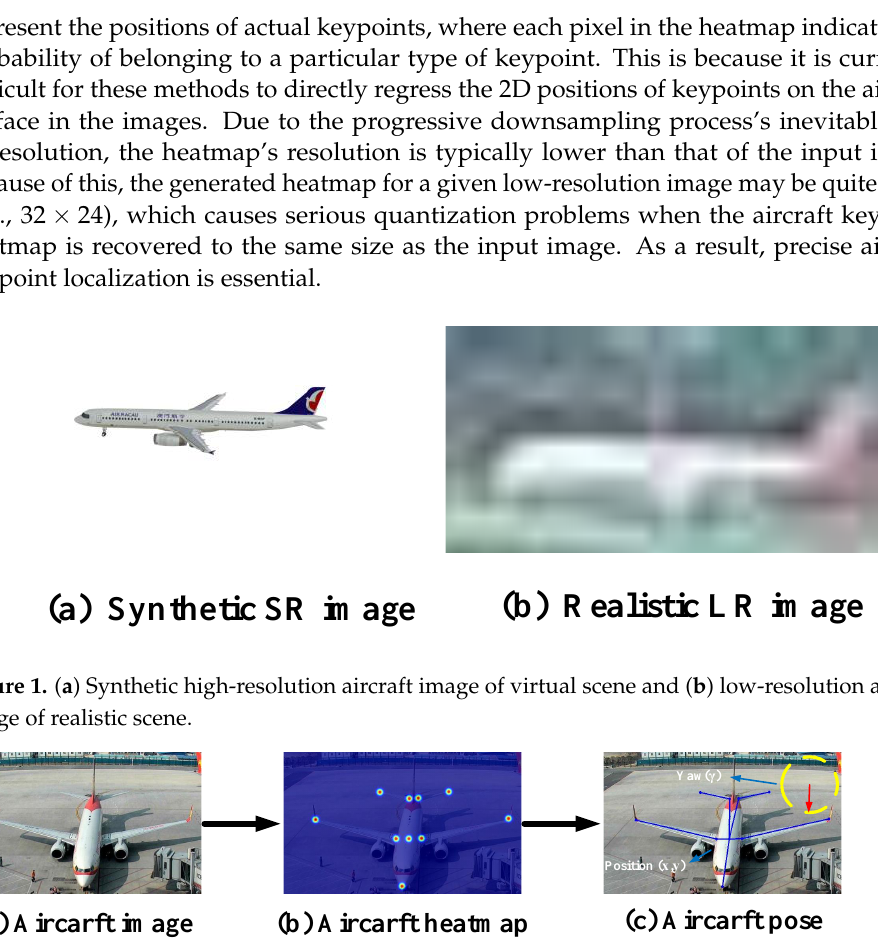
Figure 2. The pose estimation of the aircraft base on the representation of the aircraft